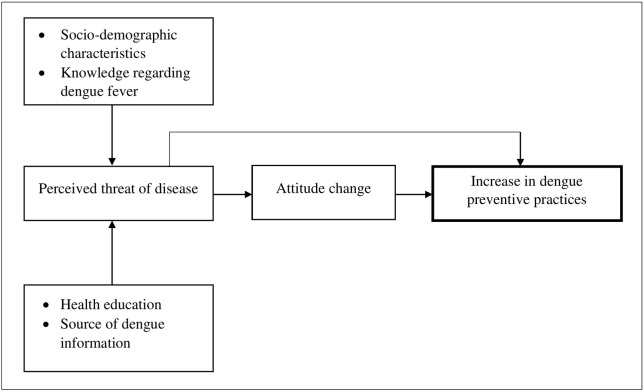
Conceptual framework of the study.